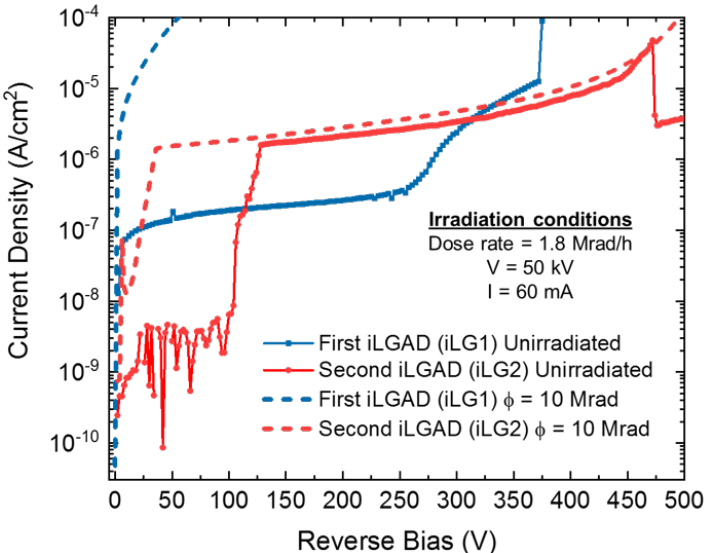
Figure 10. Current density of unirradiated and Φ = 10 MRad irradiated iLGAD detectors from the iLG1 and iLG2